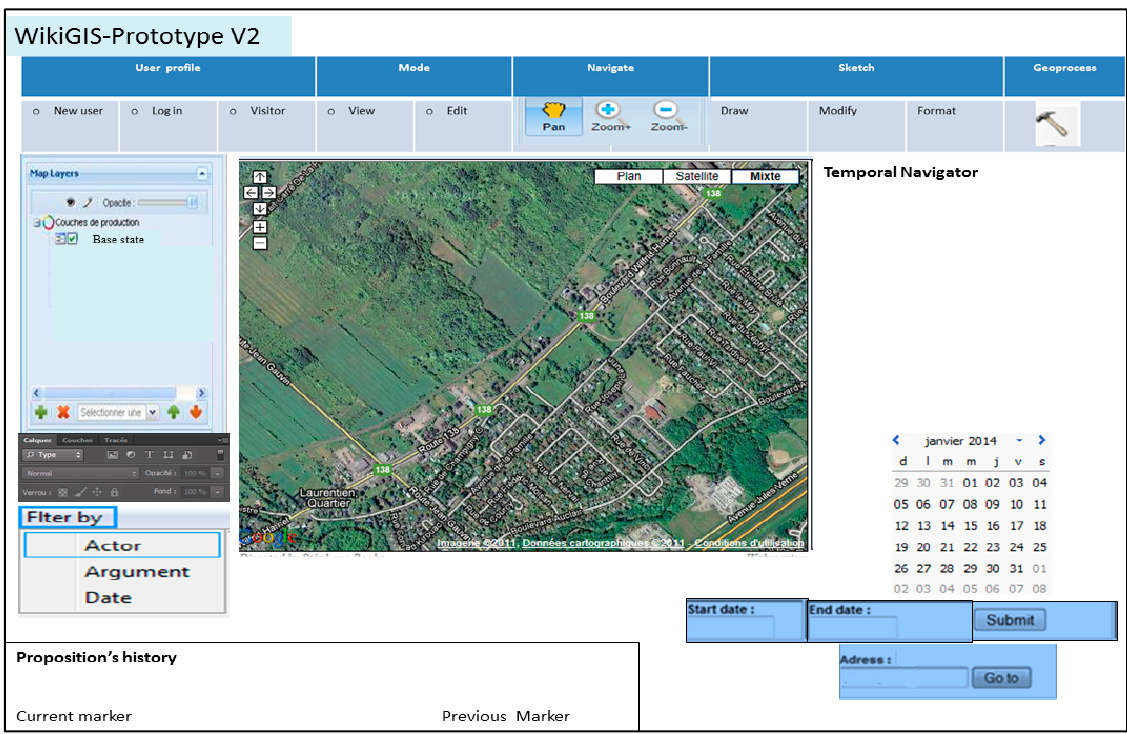
Figure 21. Cartographic iterface of WikiGIS.